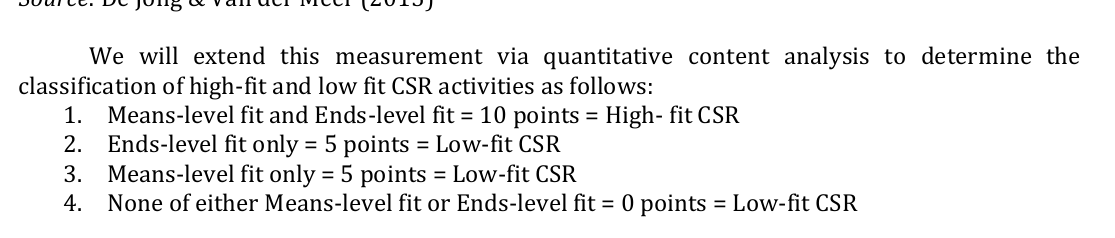
Table 1: Means-level and ends-level CSR fit Ends Level Fit No Ends Level Fit Means-Level Fit A (n=69) B (n=13) No Means-Level Fit C (n=13) D (n=7) Source : De Jong & Van der Meer